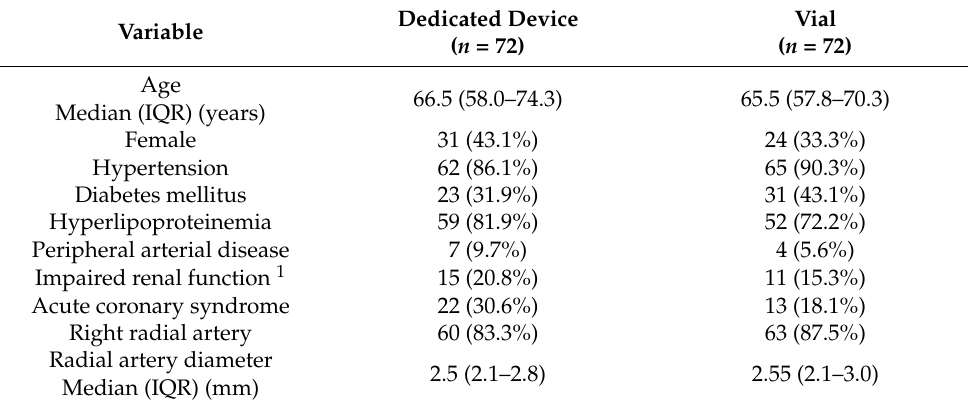
Table 1. Baseline Demographic, Clinical, and Procedural